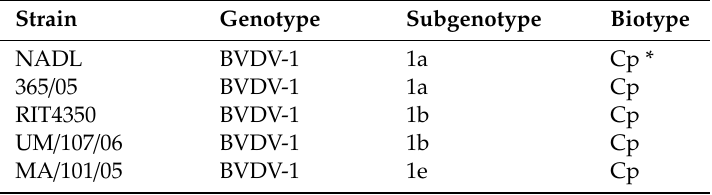
Table 2. Background details of the viral strains used in the virus neutralisation assays. Strain